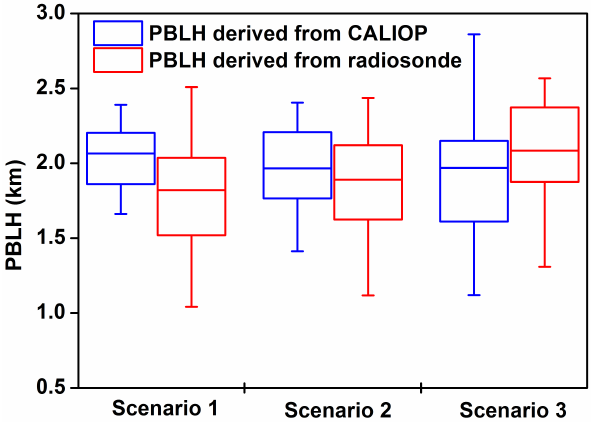
Figure 8. Box-and-whisker plot showing the 5th, 25th, 50th, 75th, and 95th percentile values of PBLH derived from CALIOP (in blue) and radiosonde (in red) for each scenario. Note that only 14:00BJT radiosonde are used to make comparison with afternoon CALIOP- derived